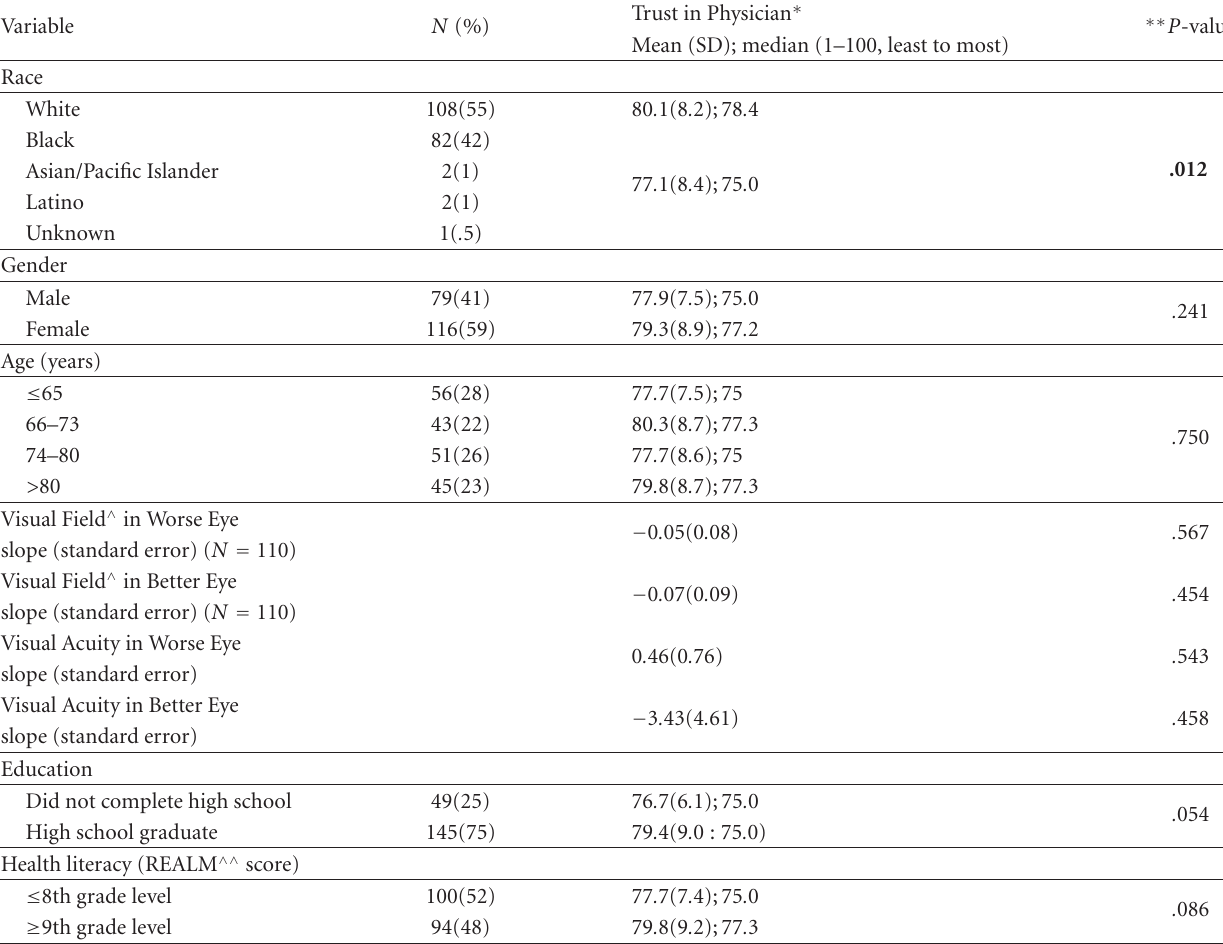
Table 2: Characteristics of 195 subjects with open angle glaucoma and factors associated with trust in physician. Trust in Physician Variable N (%)